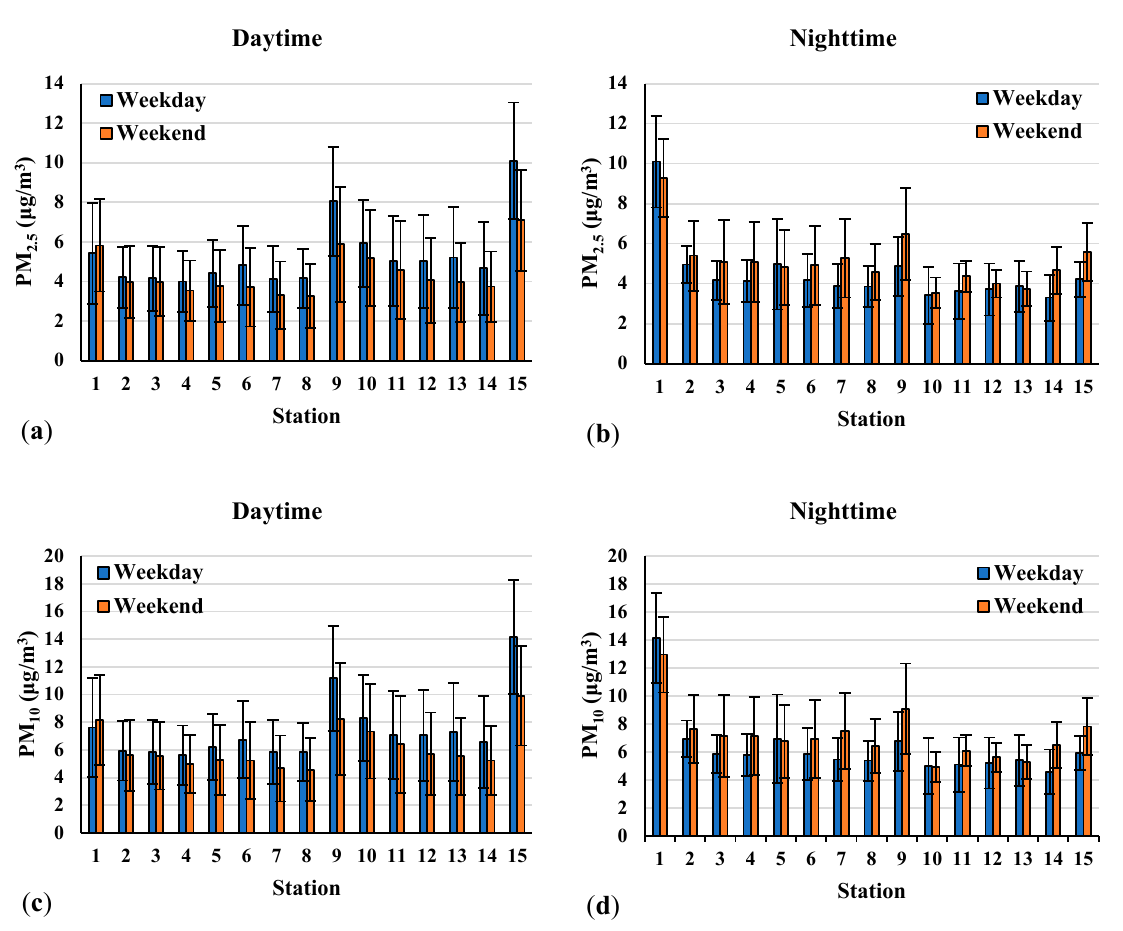
Figure 3. Average PM 2.5 and PM 10 concentrations inside the train carriage for daytime and nighttime for all 15 stations. ( a ) PM 2.5 concentrations at daytime, ( b ) PM 2.5 concentrations at nighttime, ( c ) PM 10 concentrations at daytime, ( d ) PM 10 concentrations at nighttime.